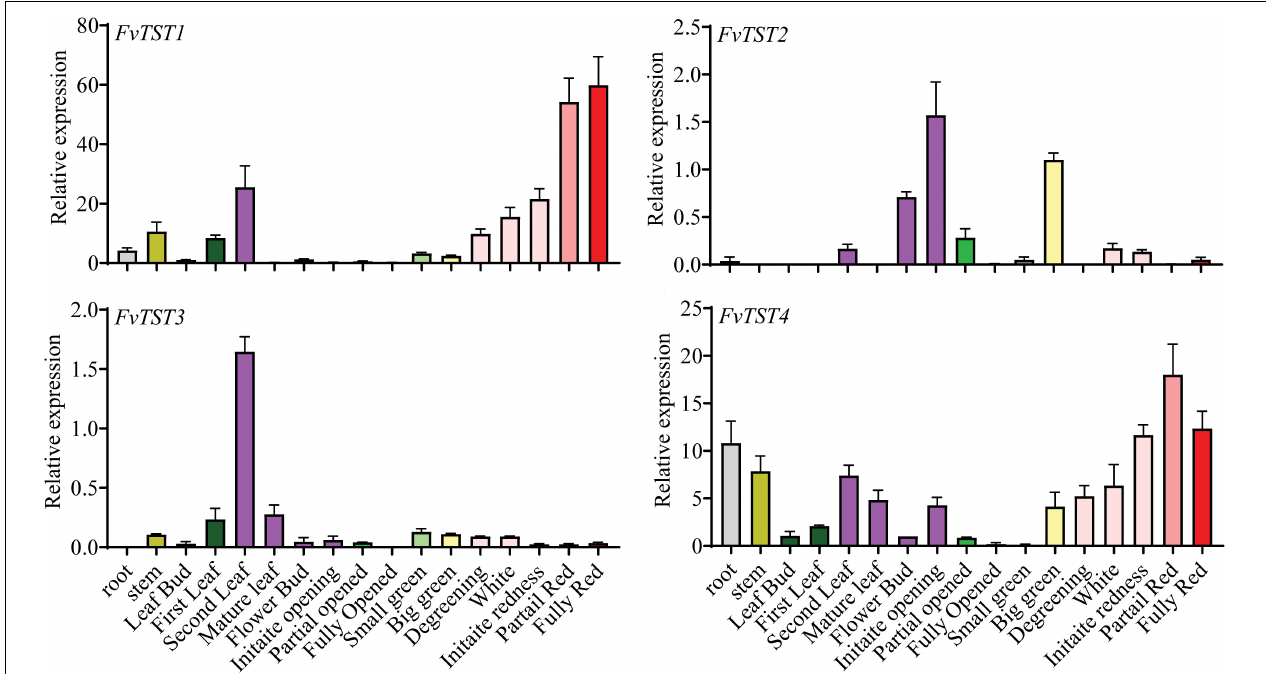
FIGURE 1 | Transcript profile of FvTSTs in different organs of strawberry in different developmental stages by quantitative real-time polymerase chain reaction (qRT-PCR). The data represent mean ± standard deviation of three biological replicates. To normalize the relative expression level, 18S rRNA was used as an internal